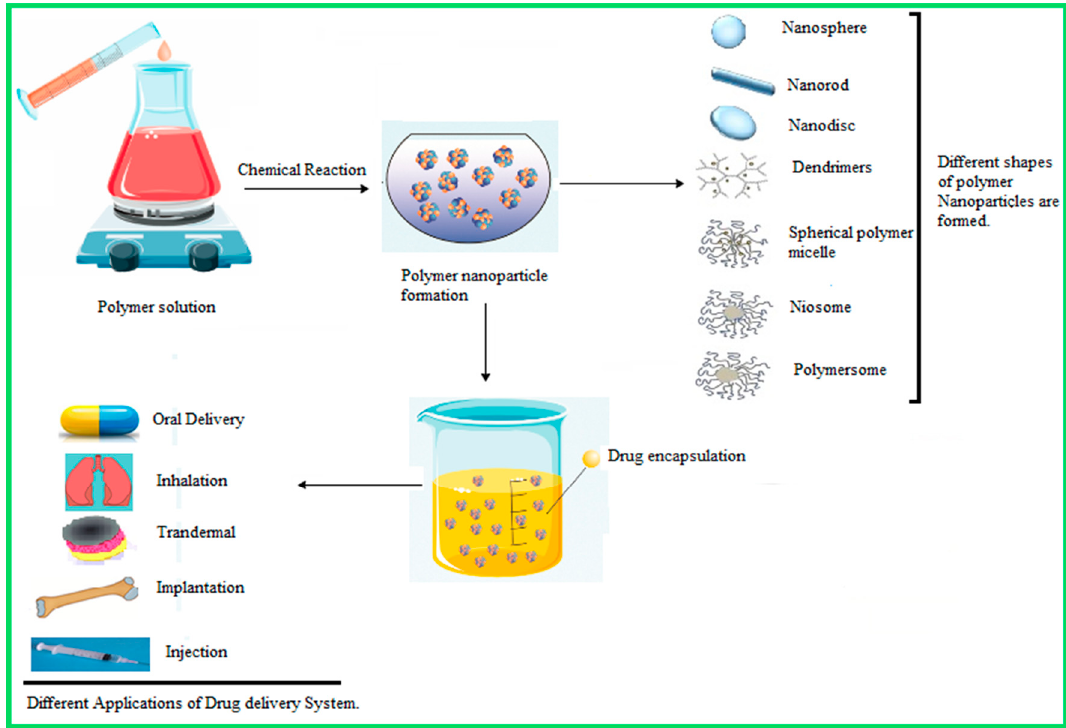
Scheme 1. Representation of the general method of synthesis/preparation of nanoparticles.